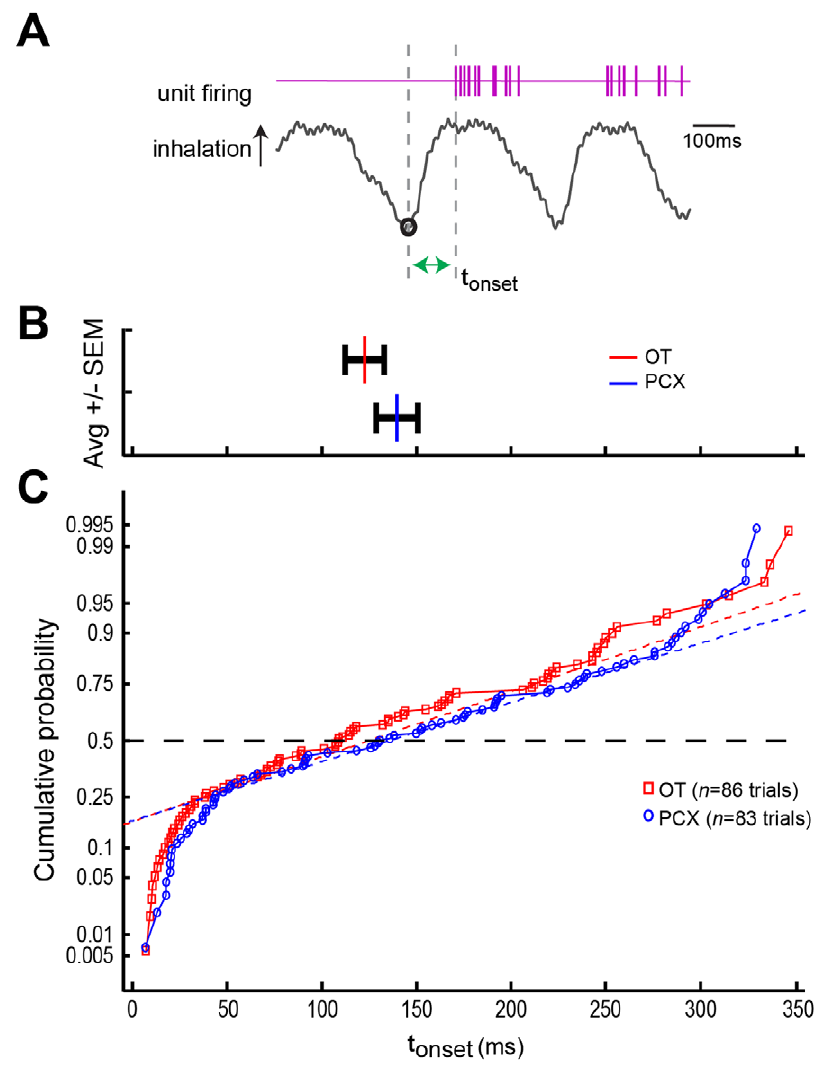
Figure 9. Onset of odor input is similar between OT and PCX. ( A ) Example traces of unit firing and respiration over the course of 1 sec. Inhalation in respiratory trace is an upward deflection. Hash marks represent unit responses (spikes). t onset =latency from first inhalation initiation during odor (circle) until the time of the first action potential (depicted here by the green horizontal arrow). ( B ) Average t onset values 6 SEM within the OT (red) and PCX (blue). ( C ) Cumulative probability plot of t onset values (same data as in (B)). Dashed lines=normal fits of OT (red) and PCX (blue) cumulative probability data.